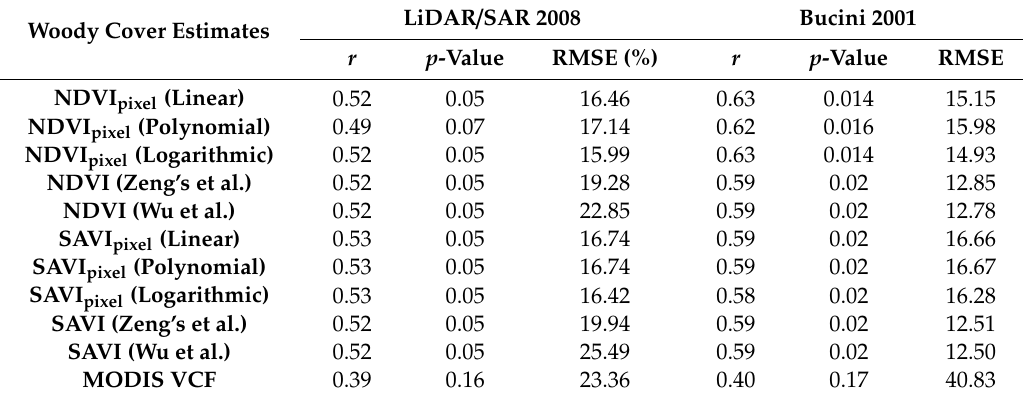
Table 5. Correlation and RMSE of estimated woody cover with LiDAR / SAR and Bucini estimates. LiDAR / SAR 2008 Bucini Woody Cover Estimates